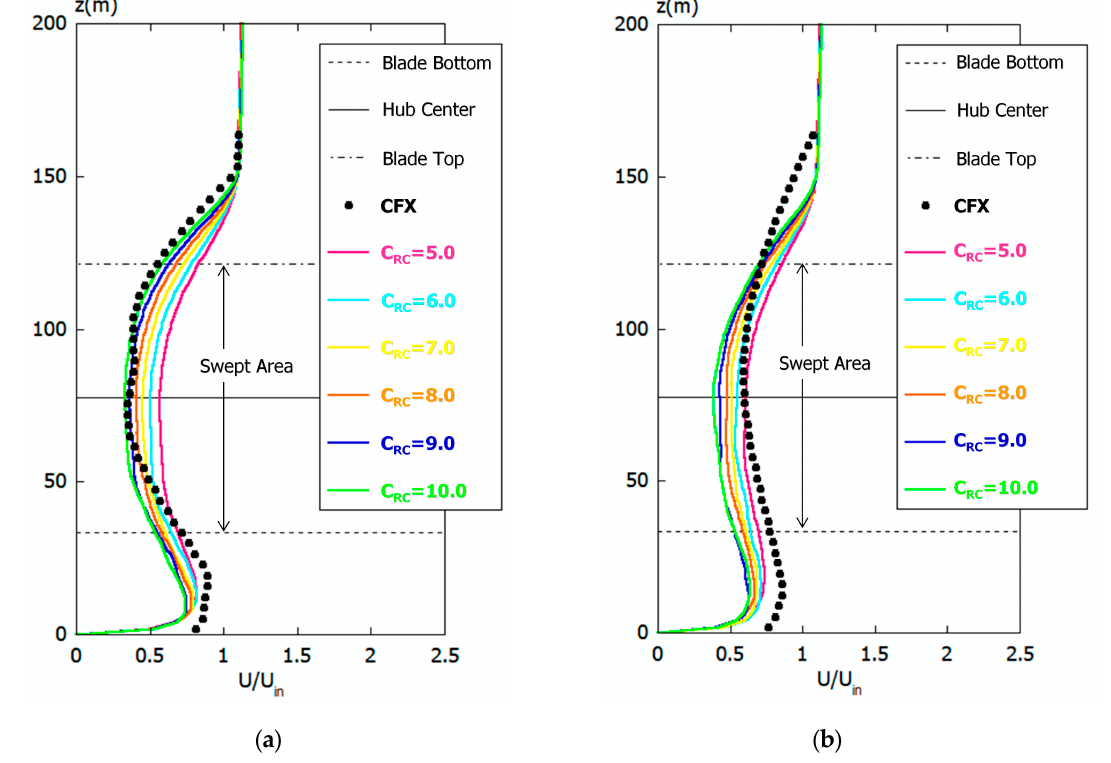
Figure 20. Comparison of vertical distribution of time-averaged U-velocities. ( a ) x = 5D (near wake region); ( b ) x = 10D (far wake region). Simulation results of a time-averaged field for a real wind turbine shown here.